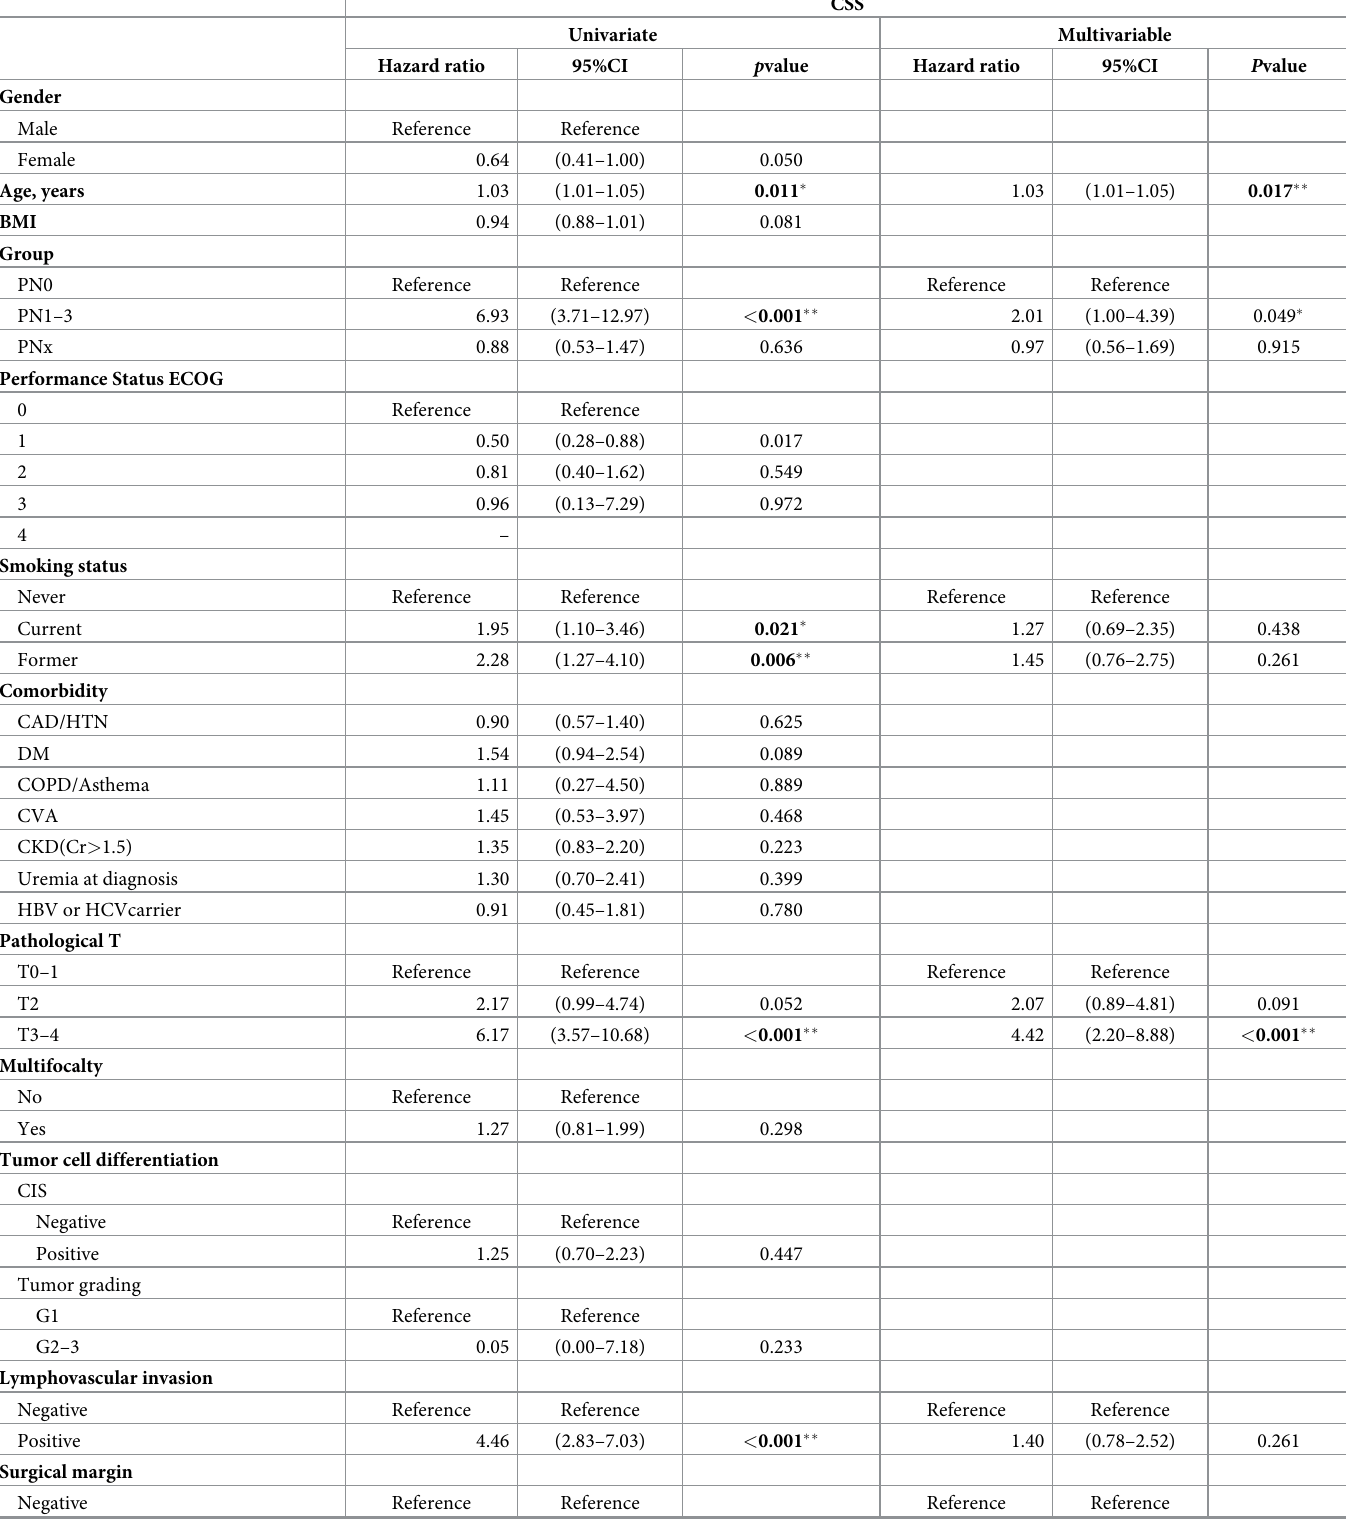
Table 2. Univariate and multivariate Cox regression analysis predicting CSS, OS, and DFS for 520 cN0 UTUC patients with pathologically proved lymph node sta- tus (pN1–3 and pN0) or without LND (pNx) undergoing RNU with